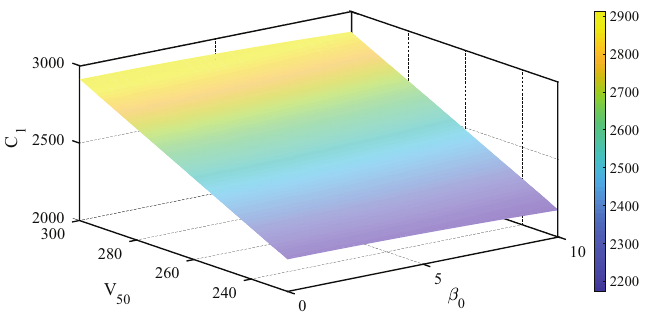
Figure 2. Surface plot of the possible values of the model parameter, C 1 , depending on the lineariza- tion point expressed in terms of V 50 and β 0